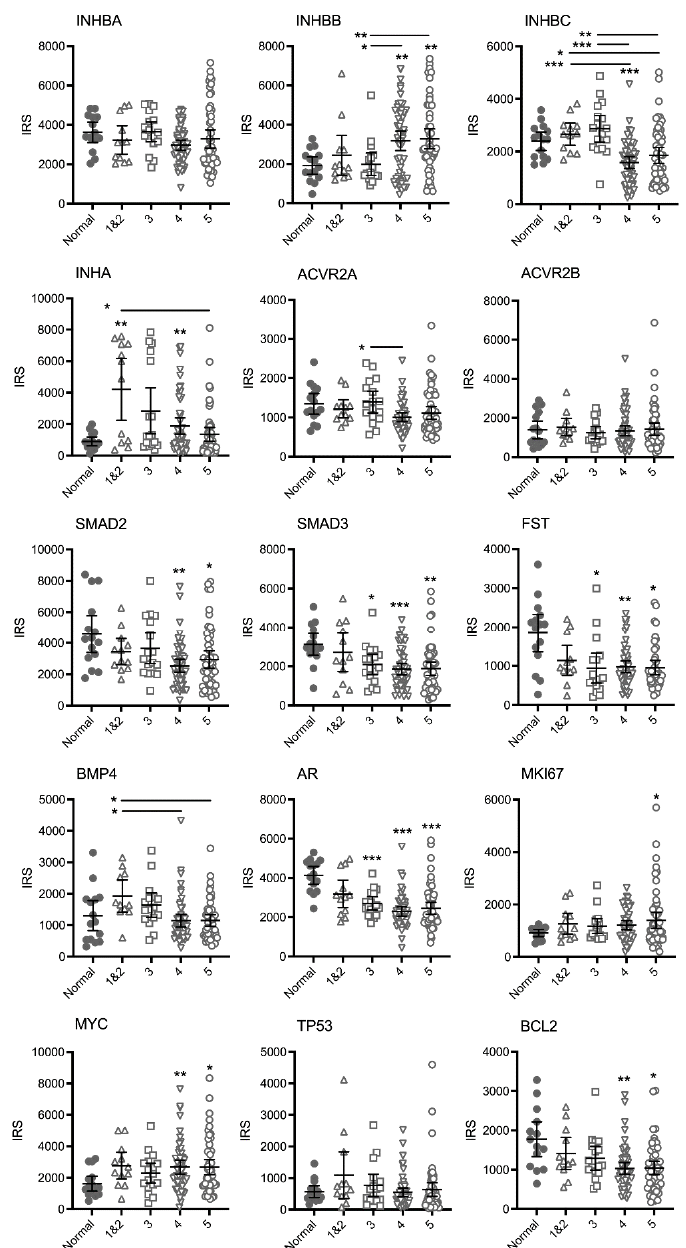
Figure 1. Graphs of IRS for individual TMA cores immunostained for TGFB family and other pro- teins relative to the highest Gleason pa tt ern present. Bars represent mean +/ − 95% con fi dence limits. Asterisks alone indicate significant differences compared to normal tissue and asterisks beside hor- izontal lines above bars indicate differences between Gleason patterns. * p < 0.05, ** p < 0.01, *** p < 0.001.